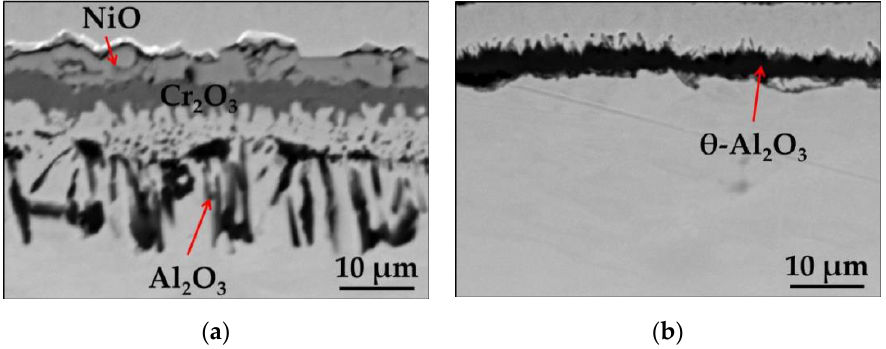
Figure 10. SEM/BSE images performed on cross-sections of Ni-14Cr-4Al model alloy after isothermal air oxidation test at 1000 °C for 24 h with: ( a ) Polished surface; ( b ) Ground surface.